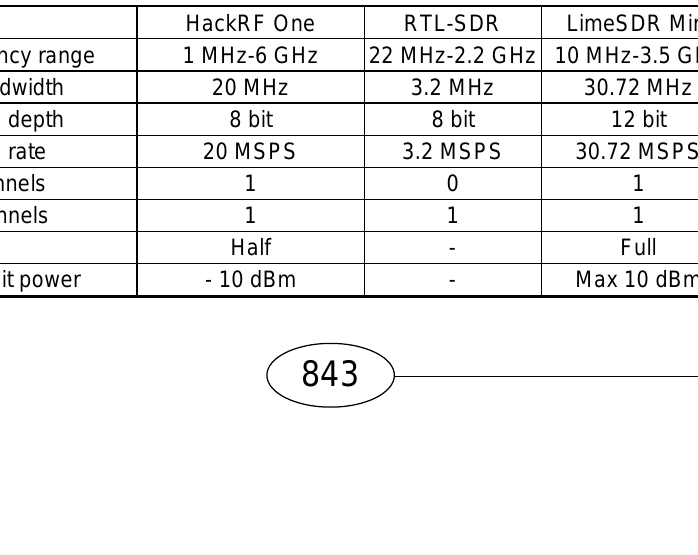
Table 2 – SDR device characteristics Таблица 2 – Характеристики устройства SDR Табела 2 – Карактеристике SDR